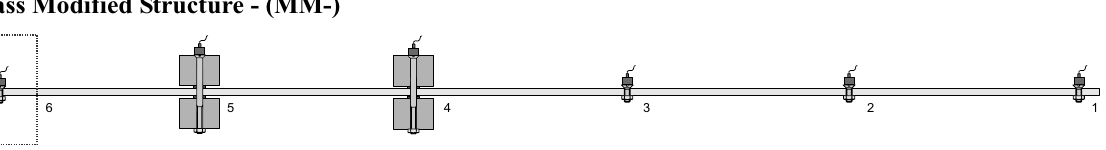
Fig. 9. System with mass modification in coordinate 6 (mass removal).